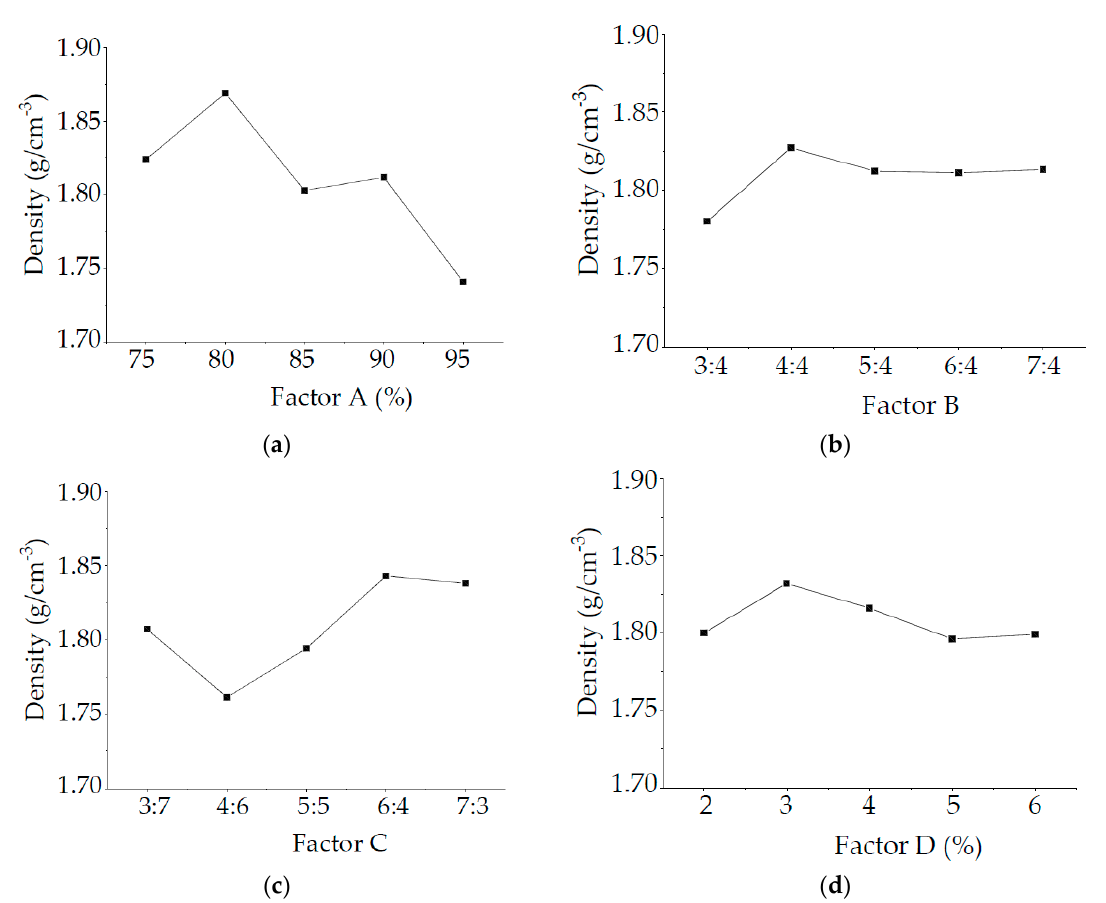
Figure 5. Intuitive analysis chart of density influencing factor: ( a ) Factor A; ( b ) Factor B; ( c ) Factor C; ( d ) Factor D. Table 4. The range analysis of the parameters of similar-materials in the orthogonal test.